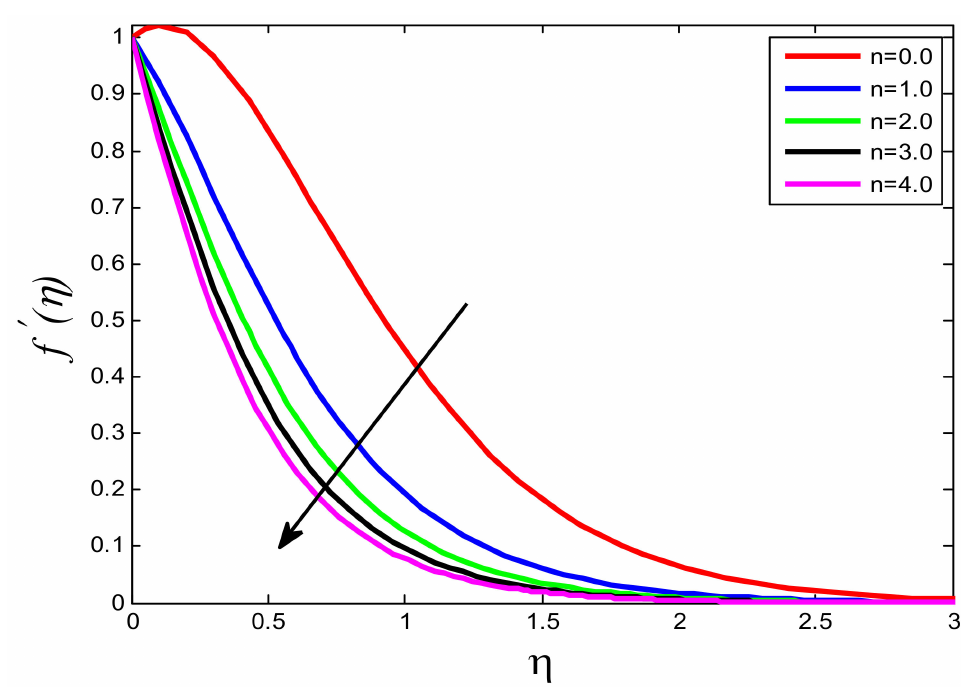
Figure 5. Influence of n on f (cid:48) ( η )